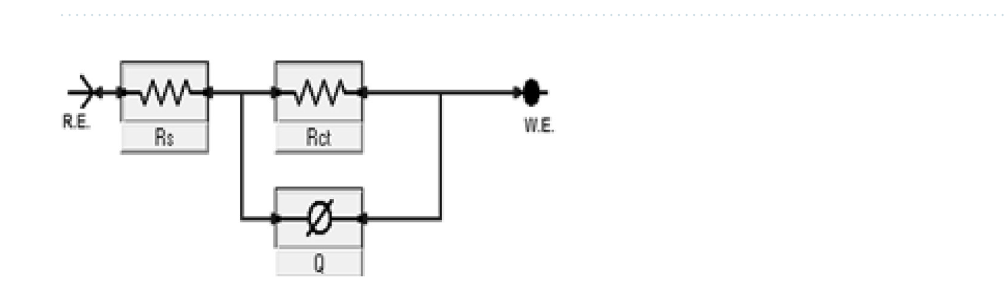
Figure 13. Impedance spectra of polarized steel in brine solution in the absence and presence of different concentrations of the copolymer 2 at 40 °C.